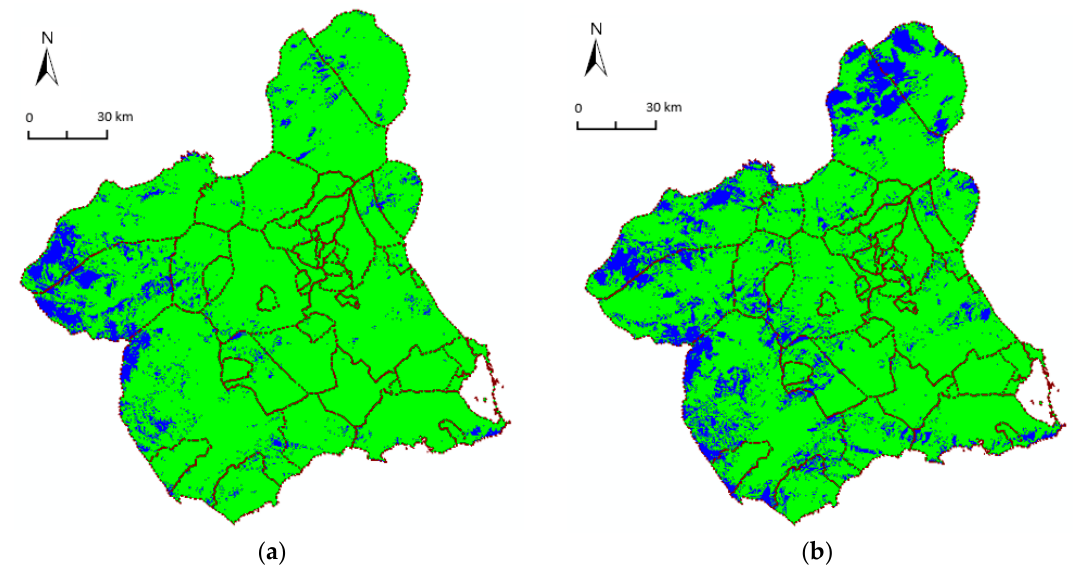
Figure 6. Radioelectric coverage for ( a ) the TETRA system (16 sites) and ( b ) the LTE system (34 sites). Table 4. Percentage of radioelectric coverage in municipal areas.